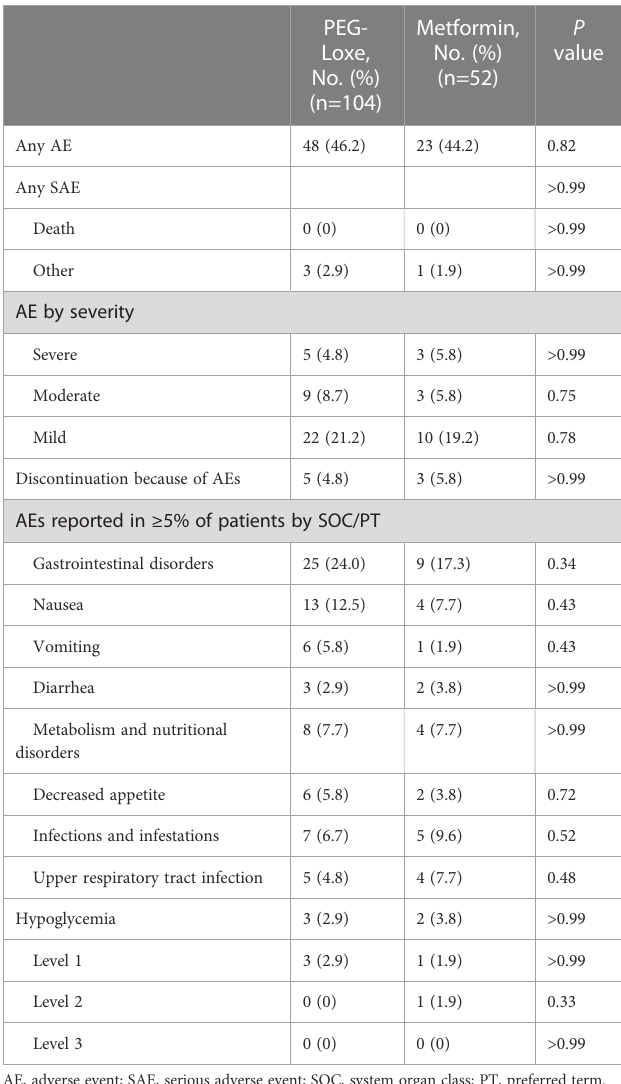
TABLE 3 Summary of